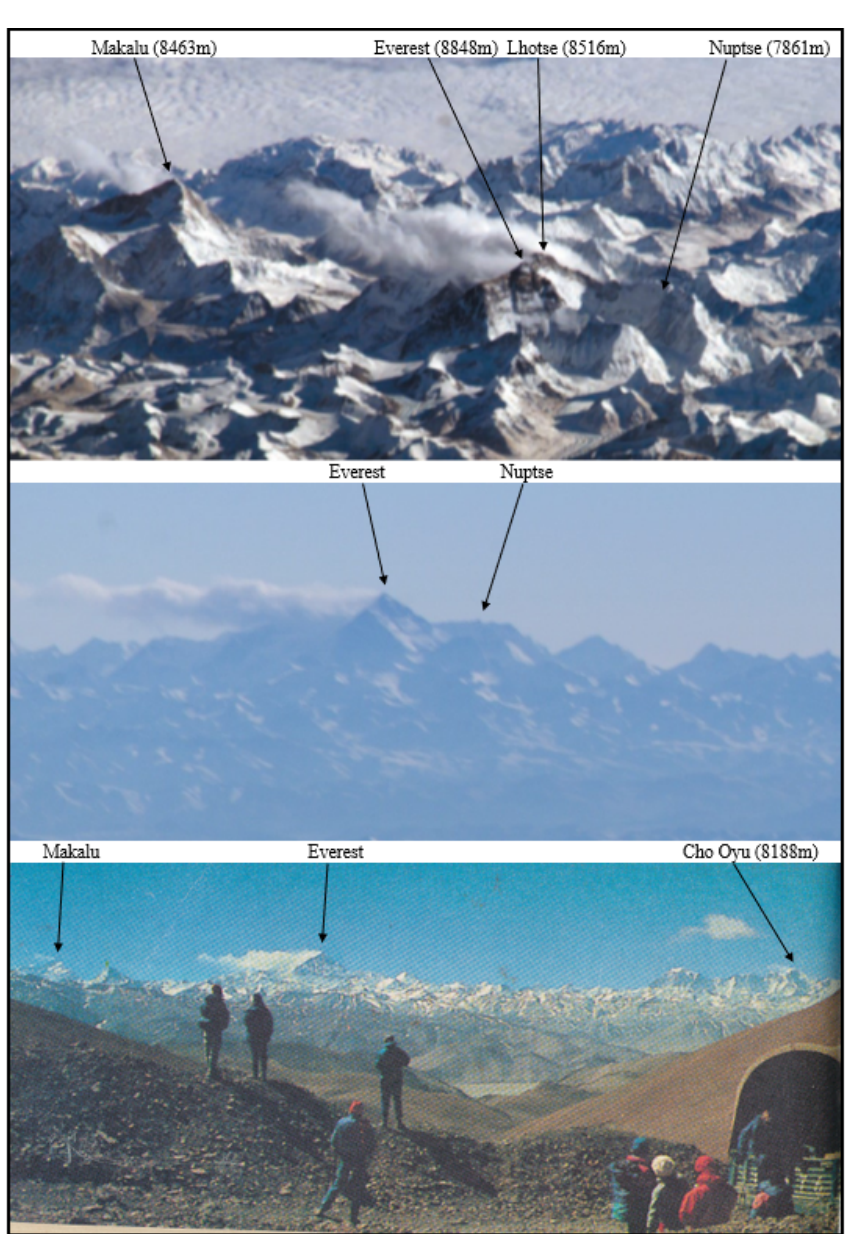
Figure 2. Top: The Everest plume studied by Moore (2004) imaged from the International Space Station (ISS) on 28 January 2004 at 10:01 UTC (16:01 LST, Local Solar Time). Middle: The plume 3min later from the ISS, not reported by Moore. Bottom: The Everest plume published in Venables (1989) photographed from the Pang La in Tibet on 6 March 1988 at about 06:00 UTC (12:00 LST). The major peaks in the images are labeled and their summit elevations are